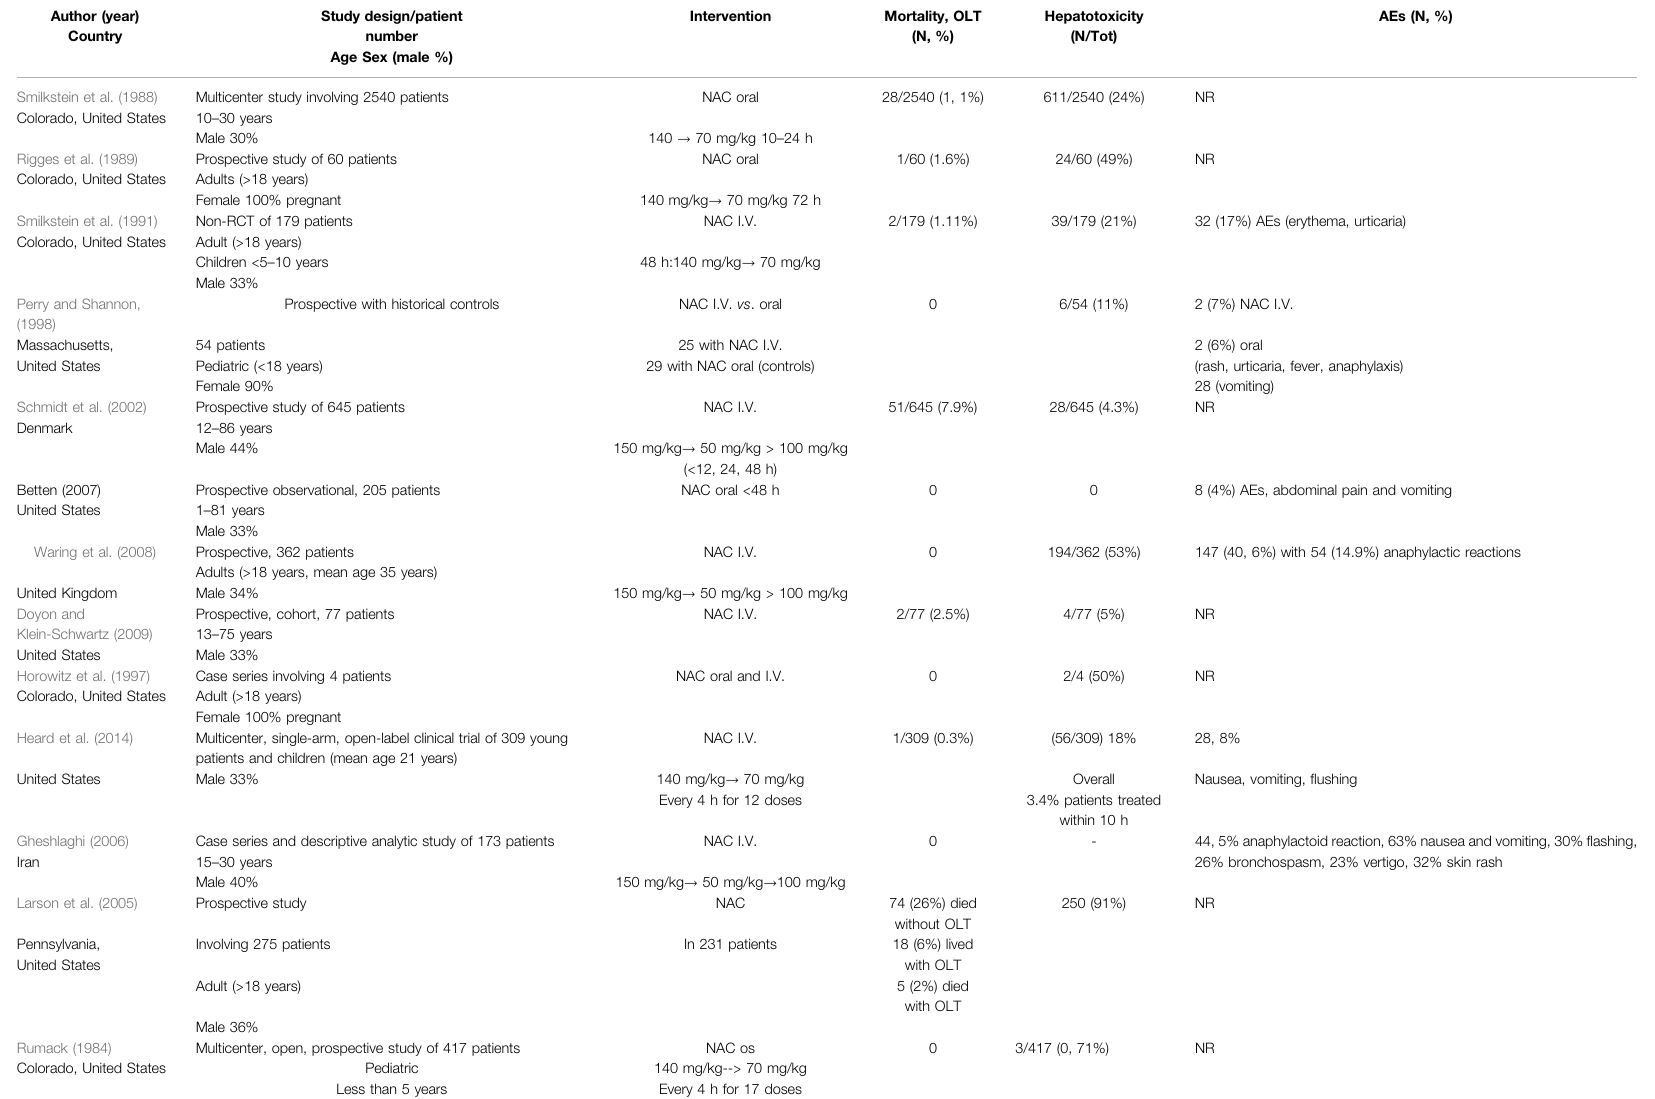
TABLE 2 | Study design characteristics and outcomes of 13 prospective studies included in the analysis. Author (year)